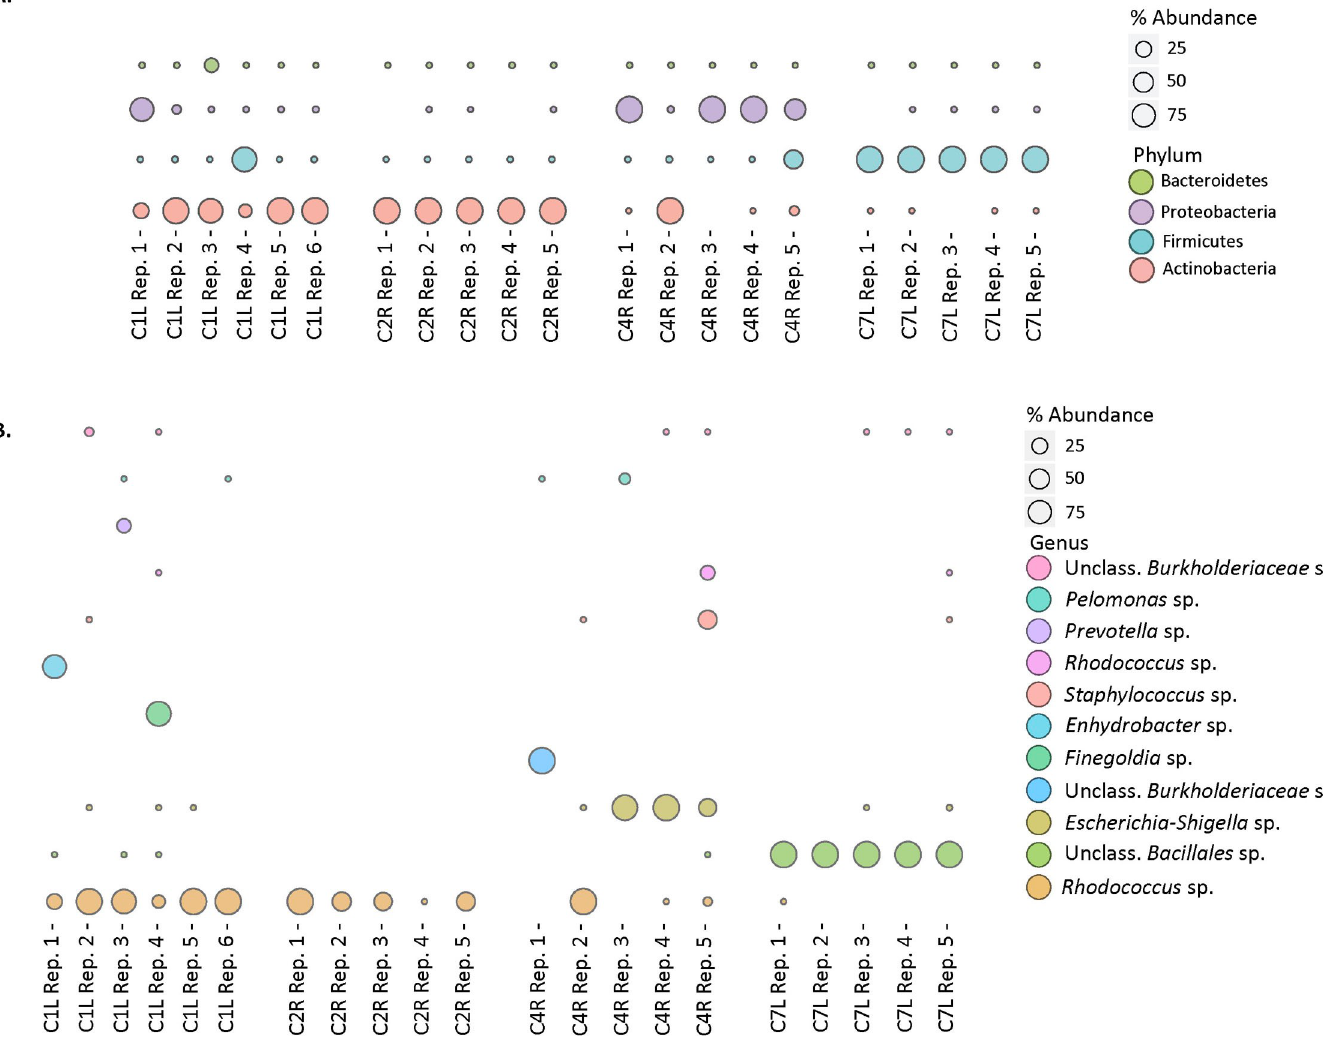
Fig 1. Microbial community composition. (a) Distribution of 16S rRNA sequences of the 4 most abundant phyla in replicate capsular samples. Bubble size per phylum represents the percentage of the total reads for each sample. (b) Distribution of the most abundant 16S rRNA sequences classified at the genus level, in replicate capsular samples. Bubbles size per genus represents the percentage of the total reads for each